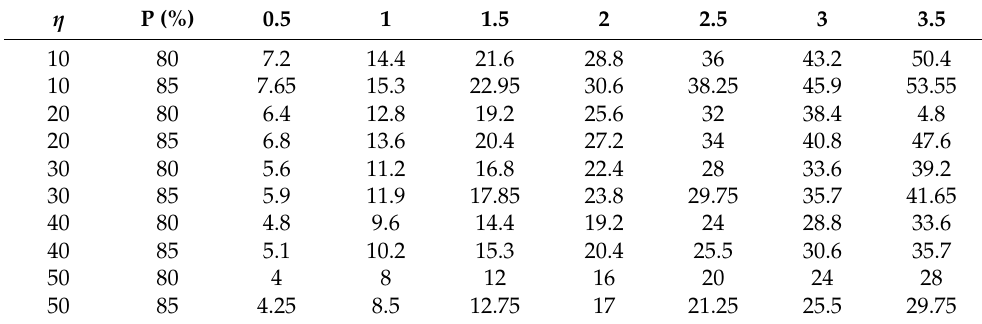
Table 2. SO 2 emission factors of coal-fired industrial boilers at 80% and 85% (P). η P (%)